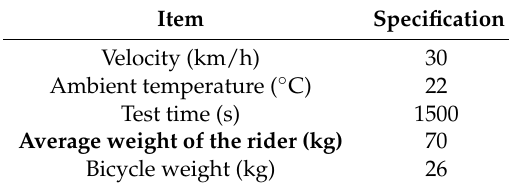
Table 5. Test Table 5. Test conditions.